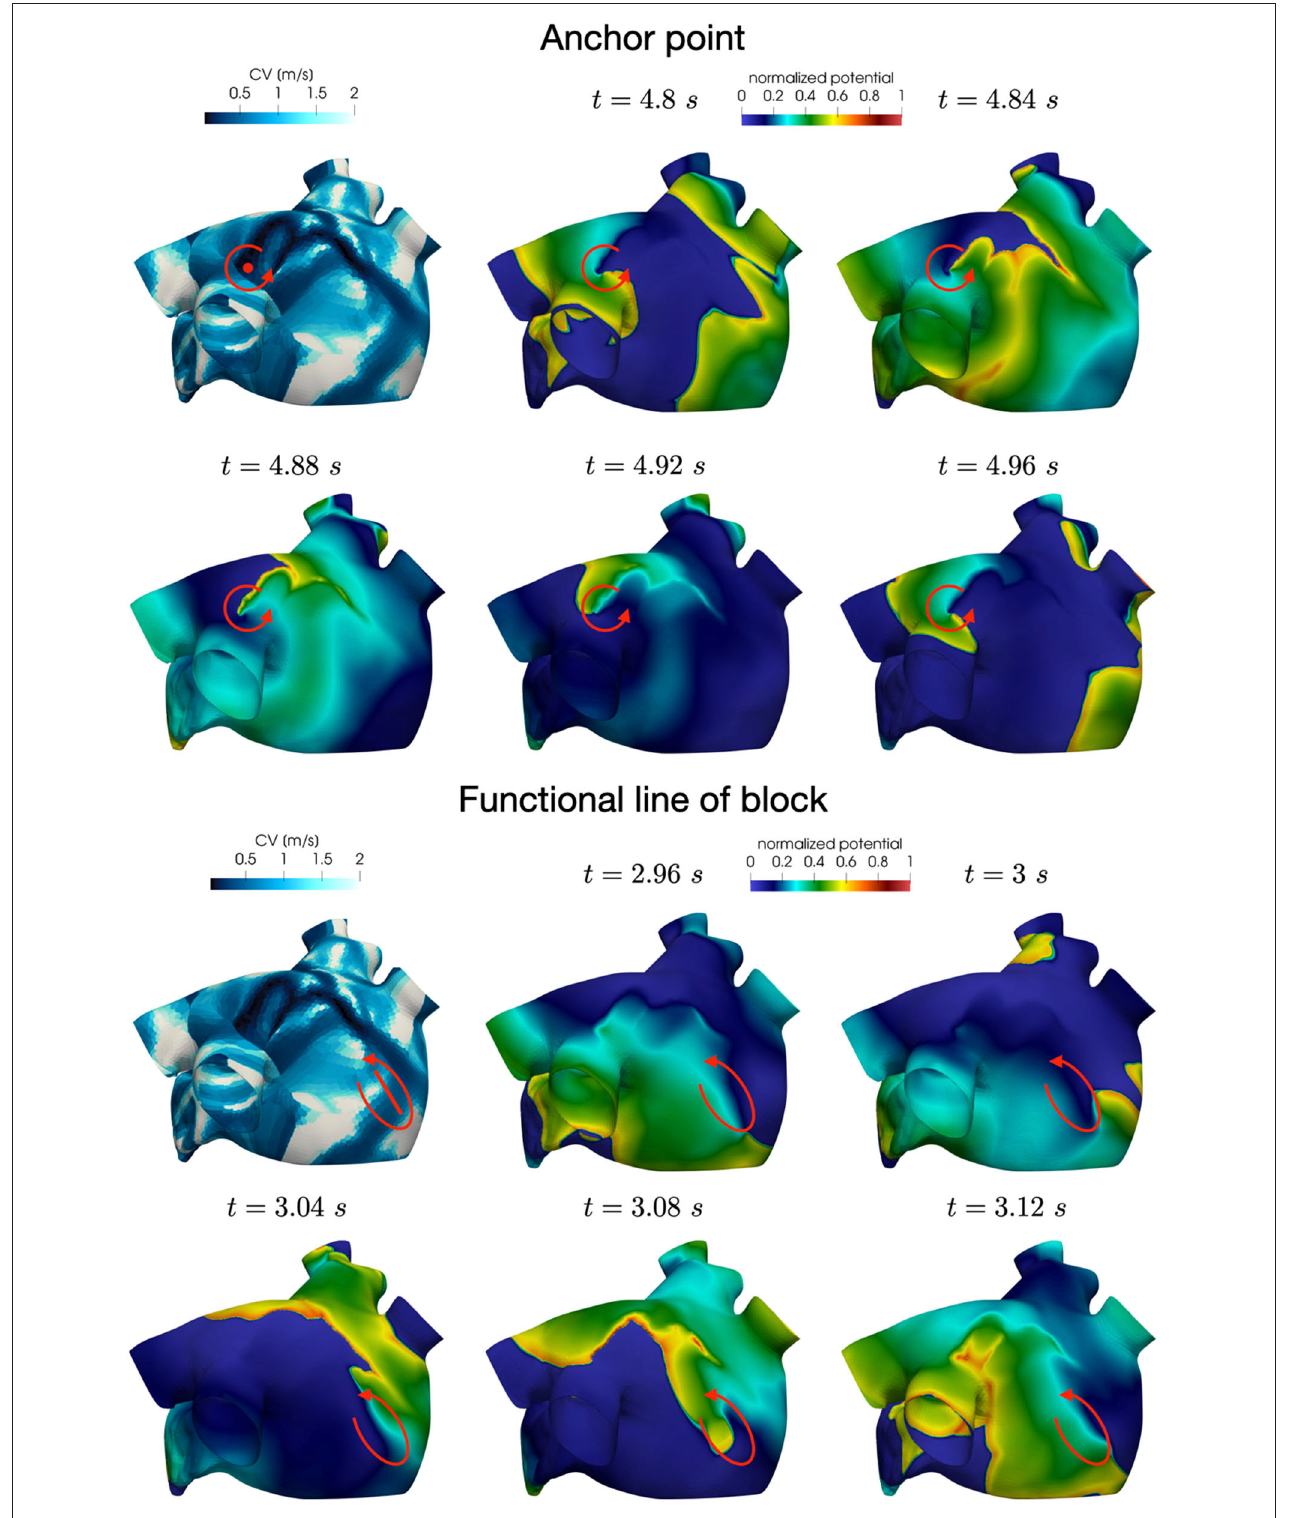
FIGURE 7 | Persistent AF: examples of two localized reentries with different anchoring sites. An anchor point, located in an area of severe slow conduction, allows rotor’s stabilization (top) . Tissue heterogeneity, instead, force the rotor to travel along a functional line of block (bottom) .